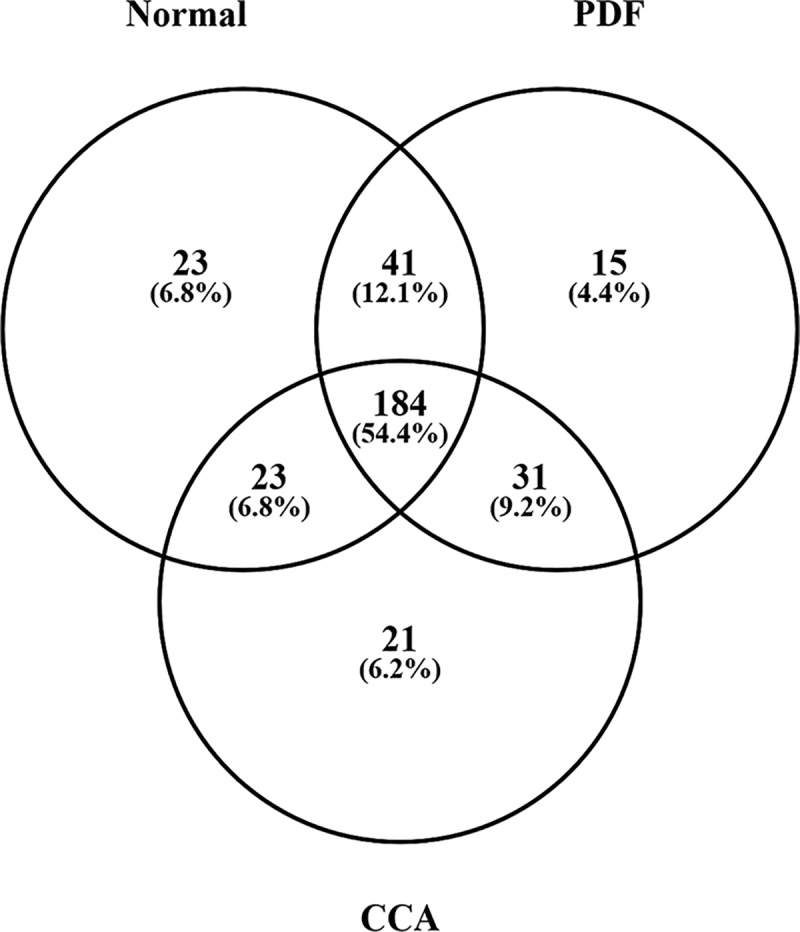
Urinary biomarker discovery.Venn diagram represents the overlap among protein sample types with 338 identified proteins.